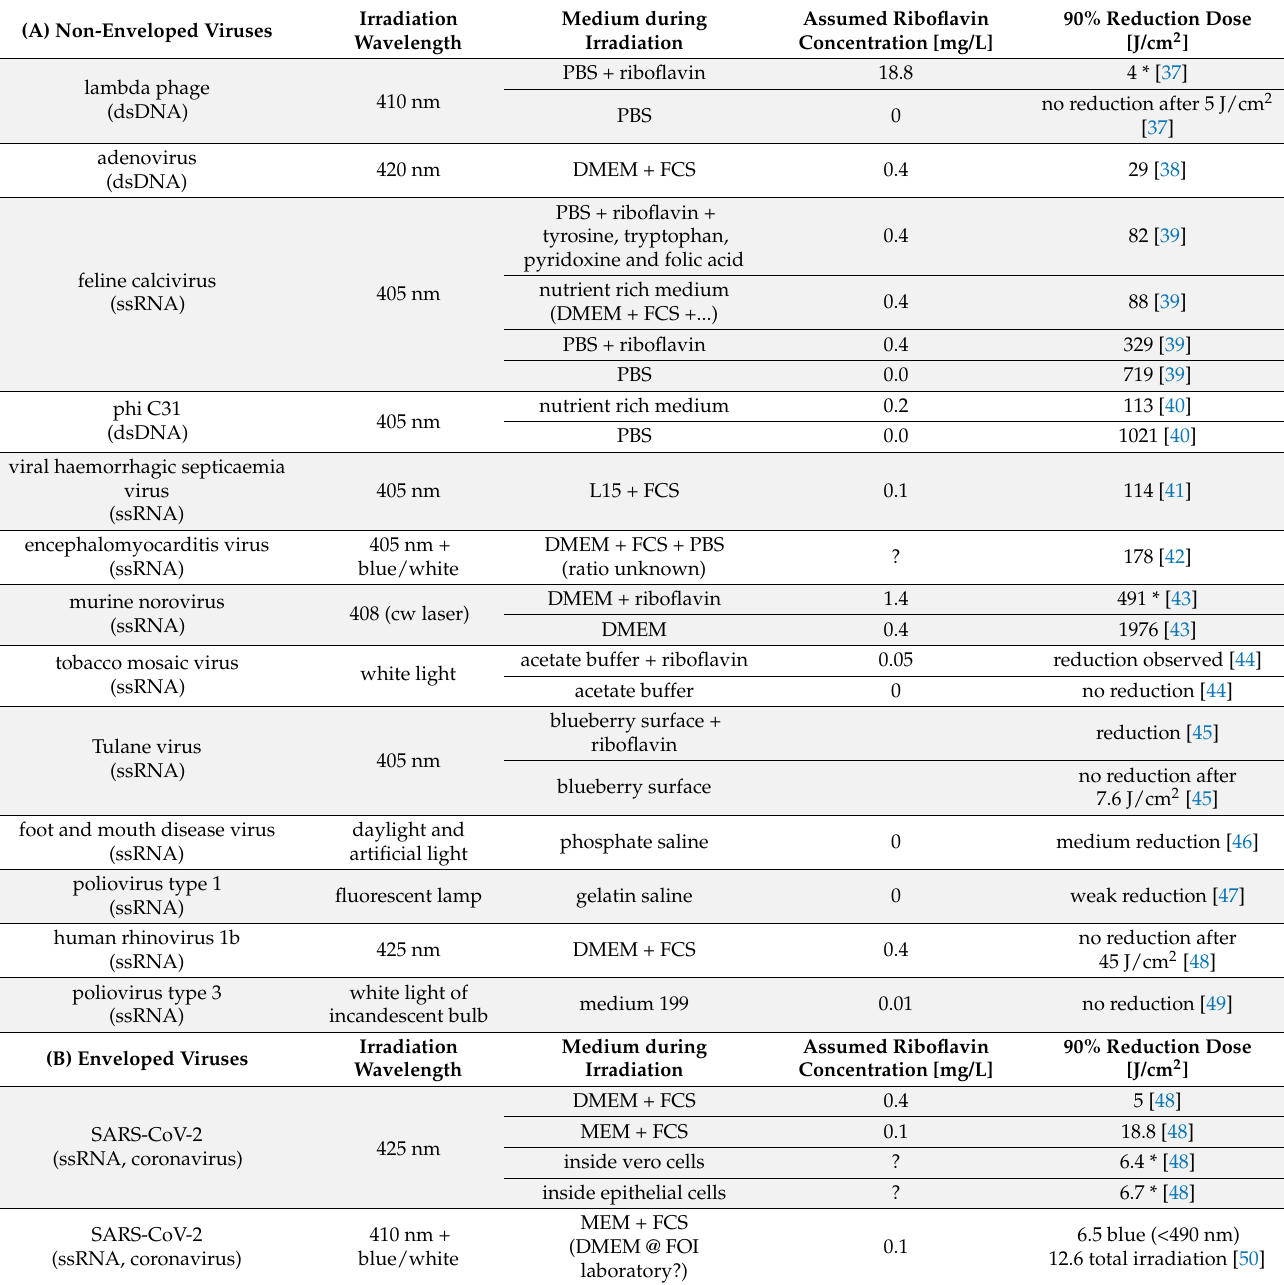
Table 1. Retrieved results for photoinactivation experiments with visible (violet/blue) light on non-enveloped (A) and enveloped viruses (B). Experimental conditions are given with the assumed riboflavin (RF) concentration and log-reduction dose, if available. If authors published results for a virus with different media or riboflavin concentrations, these are given one below the other. Results marked with * have been obtained on surfaces or at riboflavin concentrations above 1 mg/L and are not included in the further